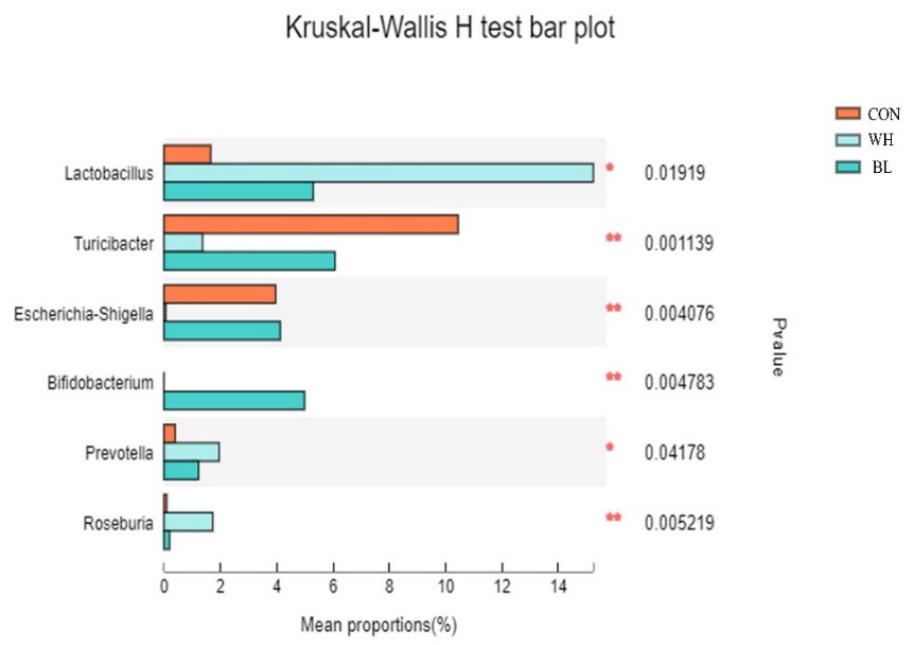
Figure 5. The fecal samples of growing pigs fed three different diets were tested for significant differences between dominant bacteria genera. The Kruskal–Wallis test, followed by Tukey’s test, was used to evaluate the statistical significance. Asterisks express statistical differences between different groups: * 0.01 < p ≤ 0.05. ** p ≤ 0.01. The individual pig was regarded as the experimental unit (n = 6). CON, basal diet group; WH, wheat diet group; BL, barley diet